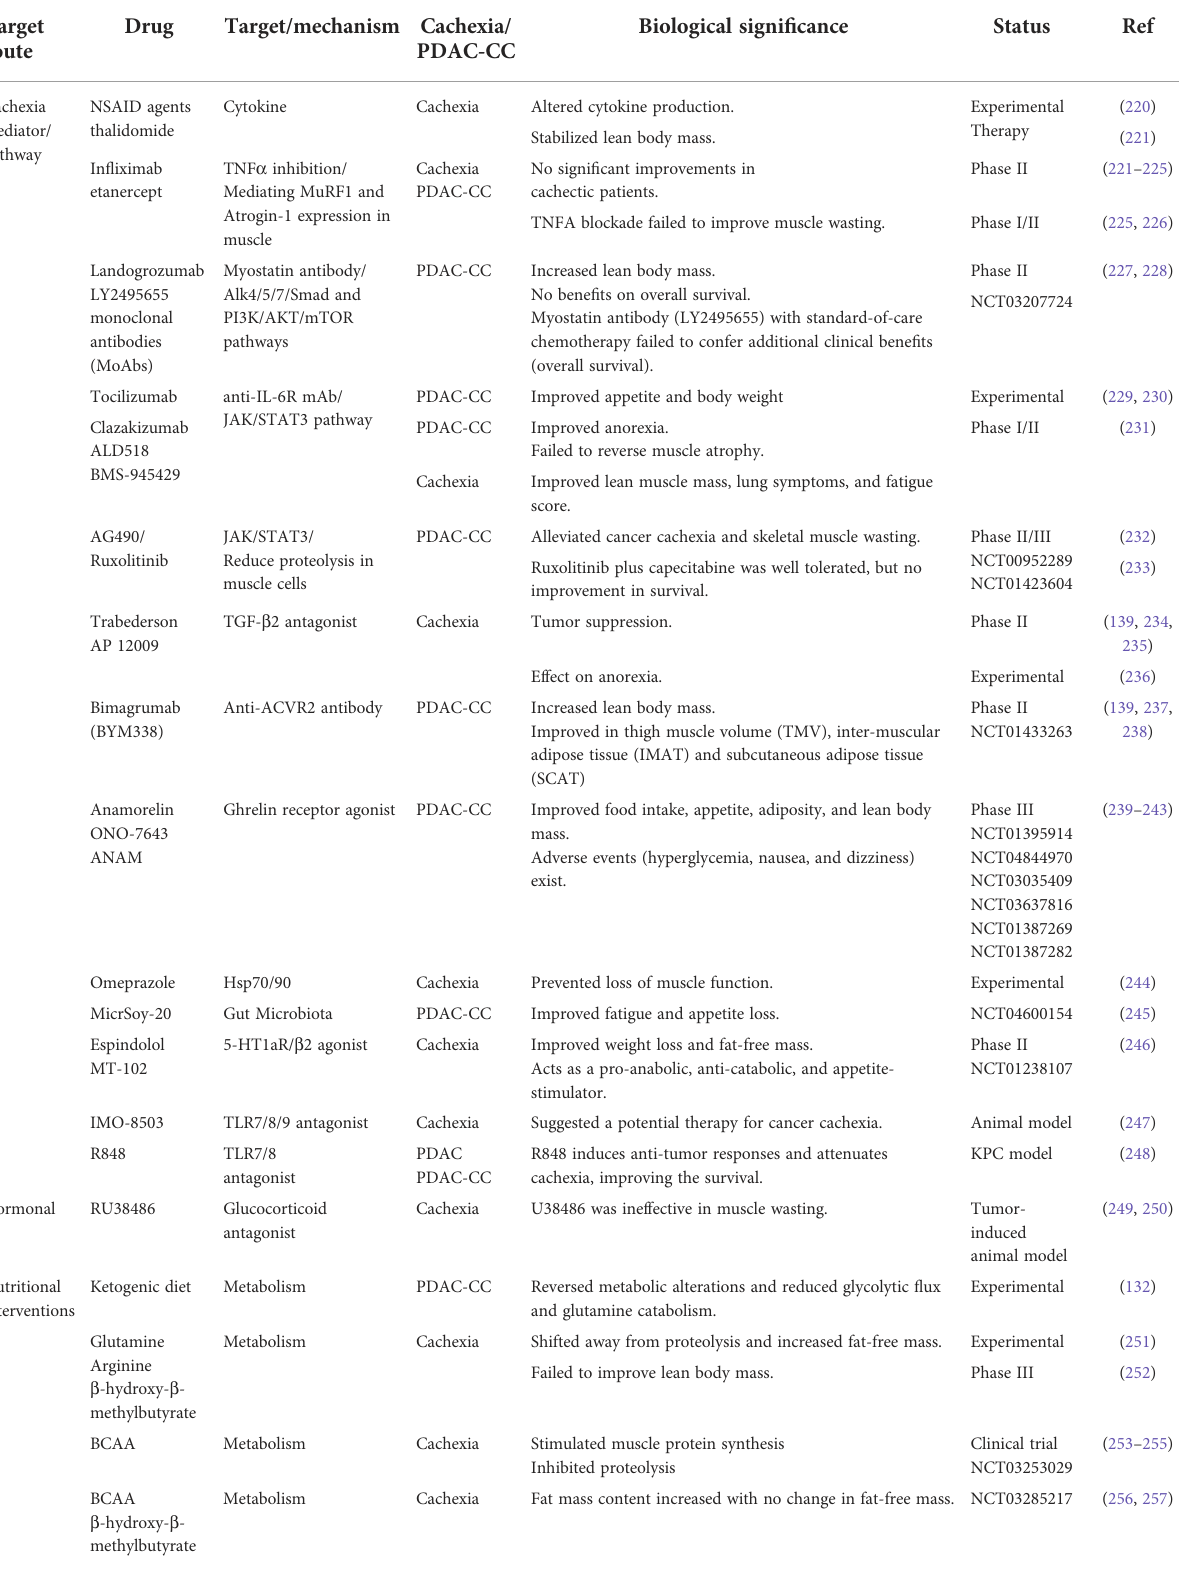
TABLE 7 Therapy for PDAC